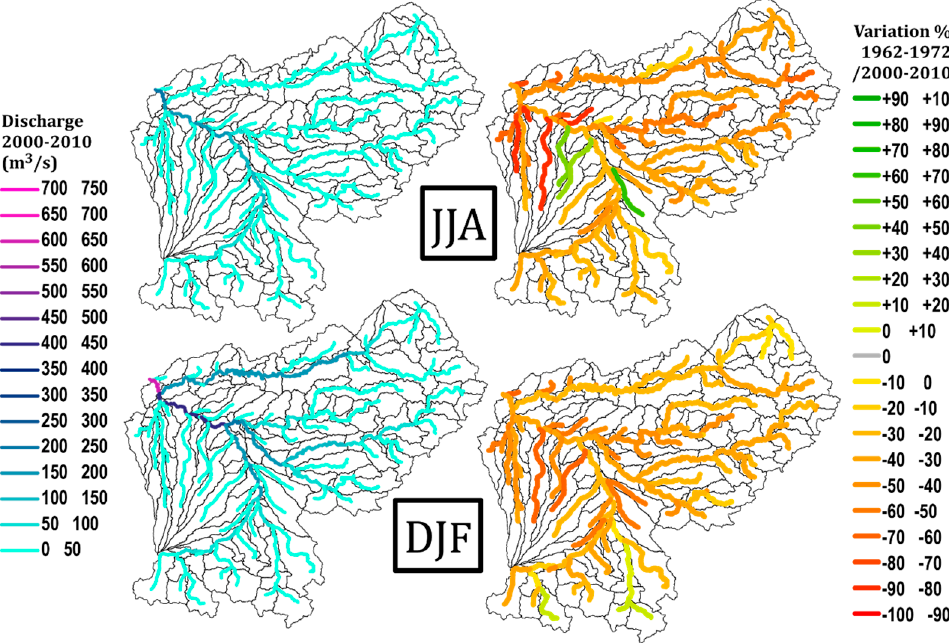
Figure 6. Discharge during the 2000–2010 decade and variations with the 1962–1972 decade. Table 6. Trend in discharge over winter (DJF) and summer (JJA) seasons at watershed scale, for SAFRAN (historical period) and climatic ensemble (projected period). Bold numbers are significant trend considering α = 0.1 and underlined numbers considering α = 0.05. Discharge DJF JJA T (trend) P